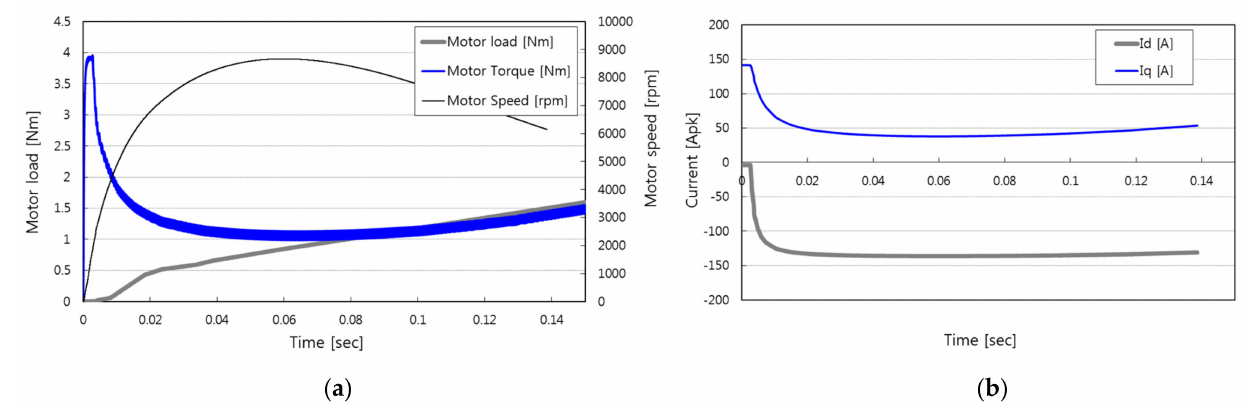
Figure 16. Transient performances of the optimized model in the rapid braking mode at 20 ◦ C: ( a ) motor speed response; ( b ) Id and